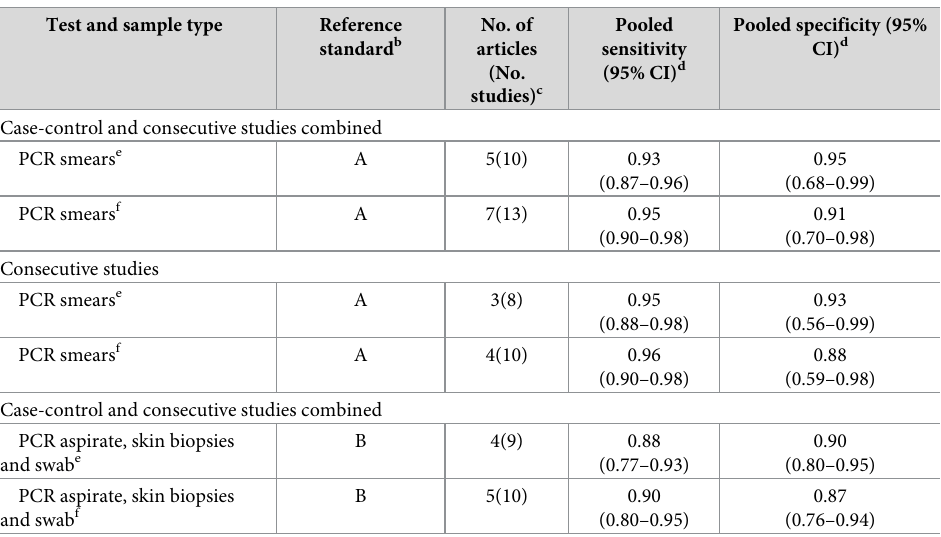
Table 2. Summary estimates for PCR a